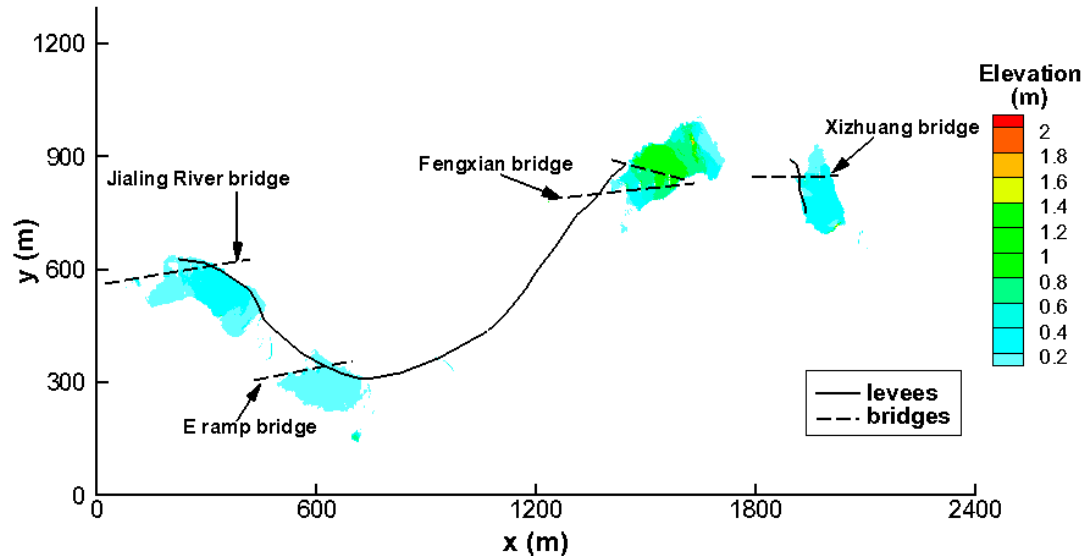
Figure 6. Differences in water levels with and without bridge piers for 10-year flood conditions.